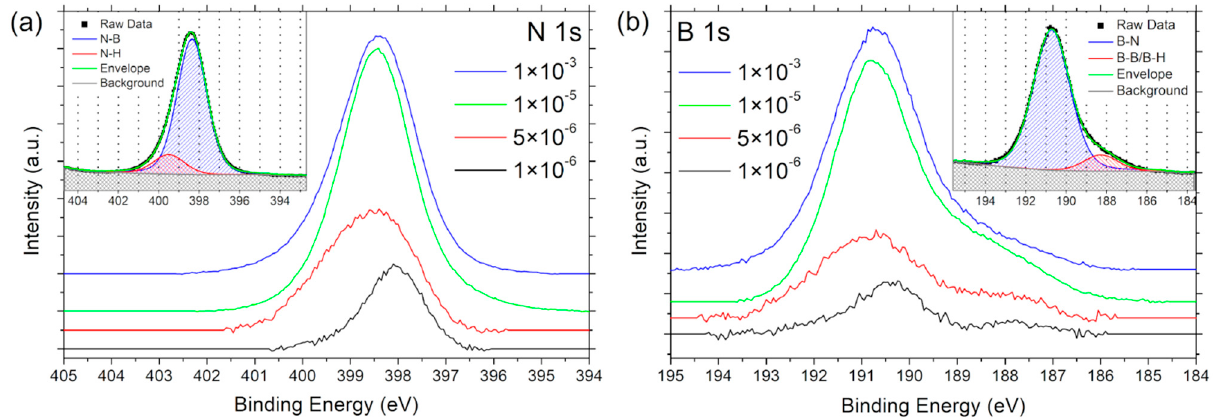
Figure 1. ( a ) N 1s and ( b ) B 1s XPS spectra of hBN films grown on Ge(001) at various pressures (in mbar). Insets show peak fit model with two components and Tougaard background, exemplified for 1 × 10 − 3 mbar.